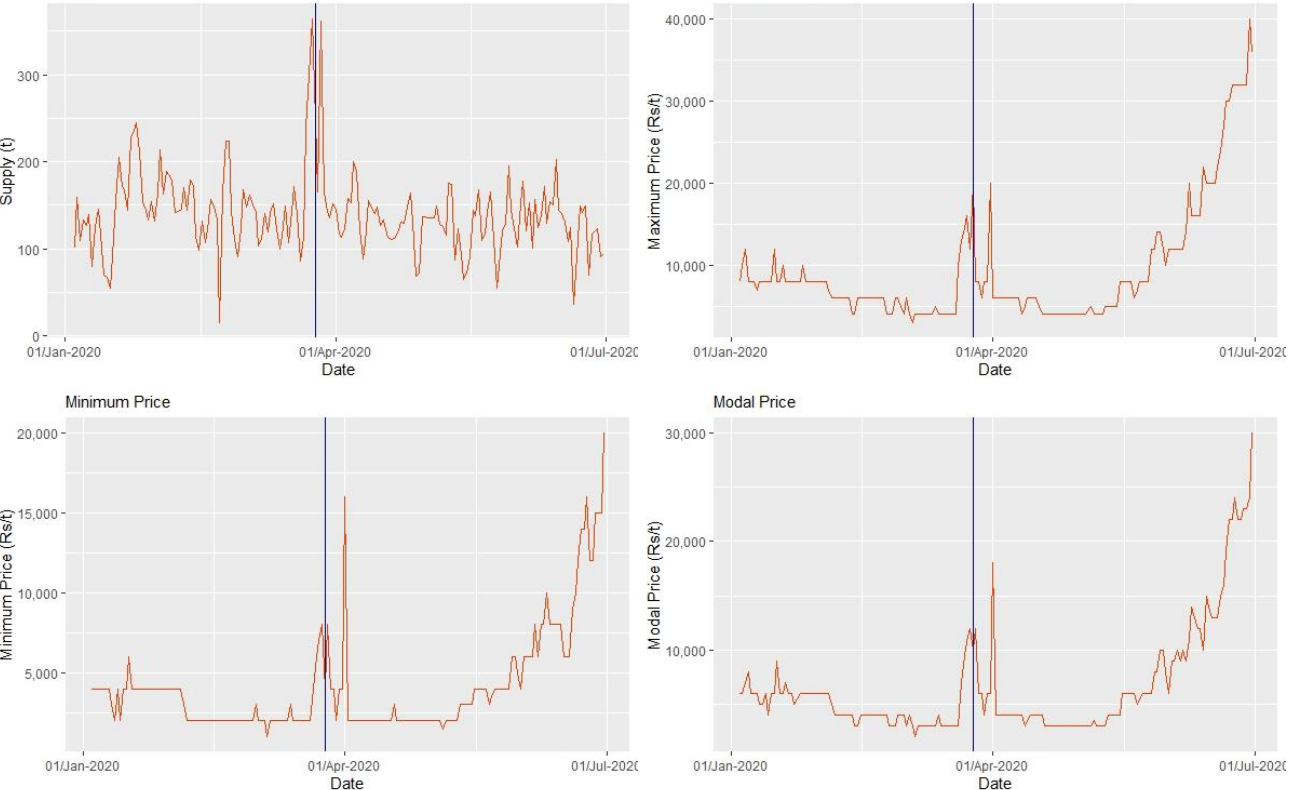
Figure 3. Time series plots of the Gudimalkapur market.